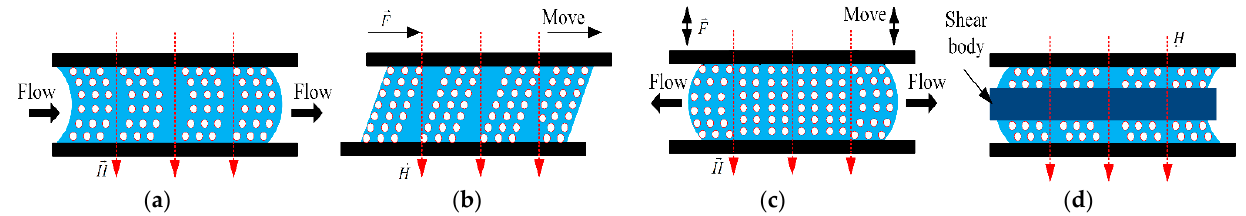
Figure 2. MRF working mode. ( a ) Flow mode; ( b ) Shear mode; ( c ) Squeeze mode; ( d ) Bi-shear mode.